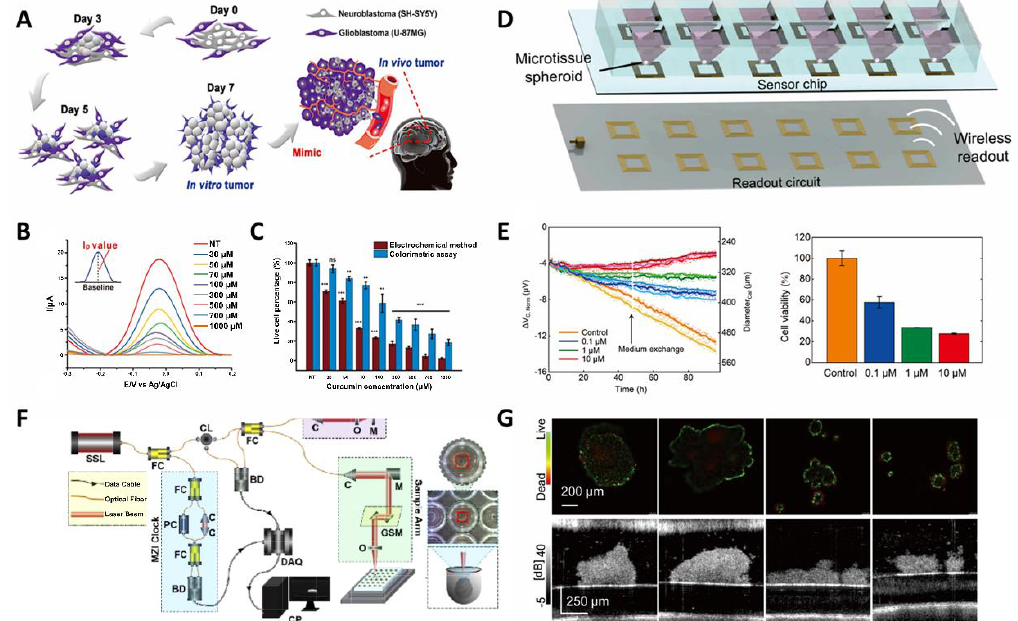
Figure 7. ( A ) Schematic diagram of a real tumor-mimicking Co-culture spheroid model. ( B ) DPV signal graph of the brain tumor model treated with varying concentrations of curcumin. ( C ) Calculated live cell percentage derived from the electrochemical signal peak (Ip a ) from ( B ) and CCK-8 results indicated in a bar graph. (Student’s t -test, N = 3, * p < 0.05, ** p < 0.01, *** p < 0.001). ( D ) An overview of the wireless impedance-based sensor platform that was connected to a PDMS microfluidic device. ( E ) Normalized ∆ Vc, Norm values of 0.1, 1, and 10 µ M doxorubicin samples and standard medium conditions (control). ∆ V C indicates evaporation-compensated voltage shift. ( F ) Validated ATP measurements of cancer spheroids after 96 h of incubation. The cell viability values were based on the control samples (the error bar indicating mean absolute errors, N = 2). ( F ) Schematic of the OCT system for 3D imaging of the spheroid. ( G ) Cross-sectional drug toxicity evaluation of the MCF7 spheroids. The upper panel shows the fluorescence images and the lower panel shows the results obtained through the OCT intensity microscopy. Reprinted with permission from [122]. Copyright 2020, Wiley Online Library; Reprinted with permission from [121]. Copyright 2020, American Chemical Society; Reprinted with permission from [146]. Copyright 2021, Optical Society of America; Reprinted with permission from [110]. Copyright 2020, Optical Society of